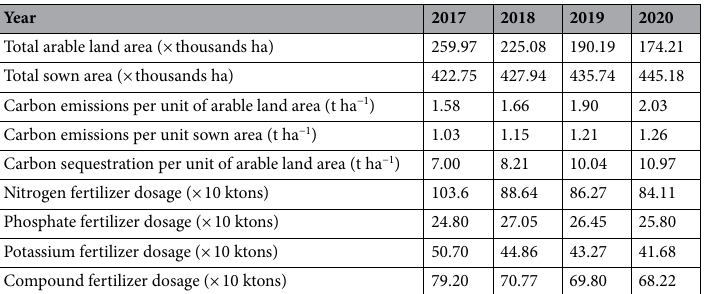
Table 3. Inter-annual variation of selected factors in Guangdong agro-ecosystems,